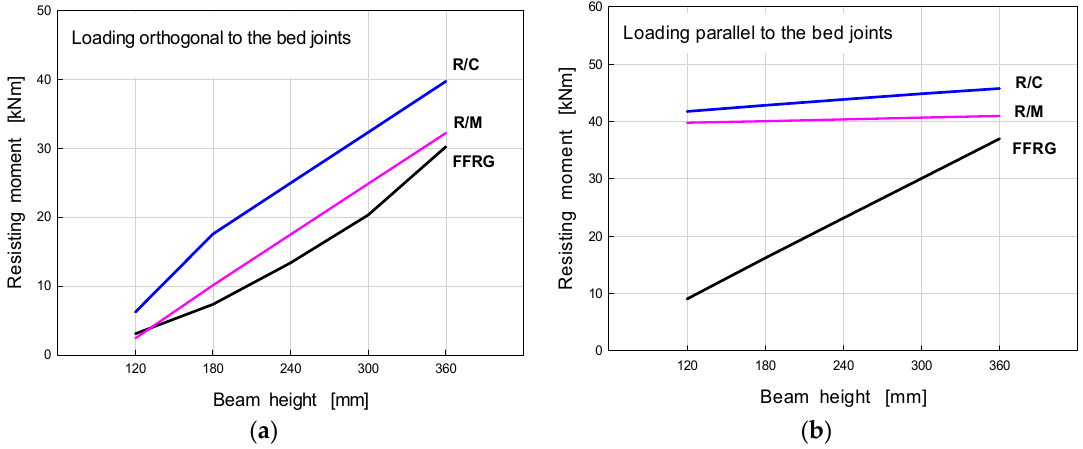
Figure 10. Comparison among the resisting moments of ring-beams in several materials: ( a ) loads orthogonal to the bed joints; ( b ) loads parallel to the bed joints.